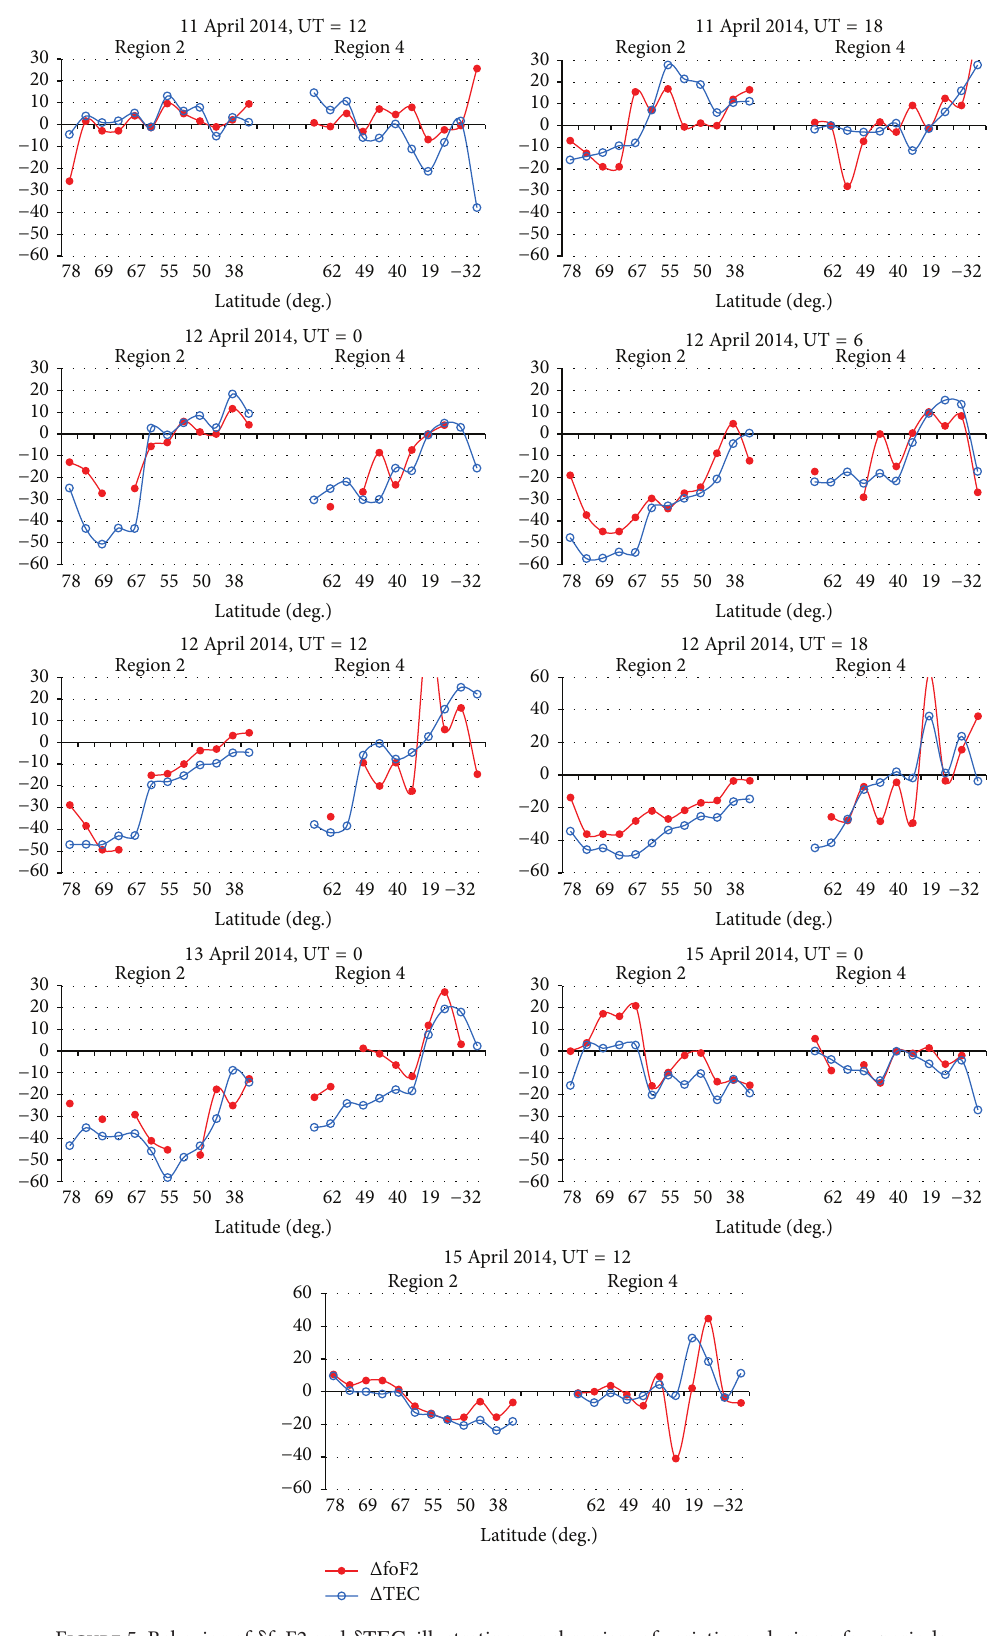
Figure 5: Behavior of 𝛿 foF2 and 𝛿 f@b , illustrating synchronism of variations, during a few